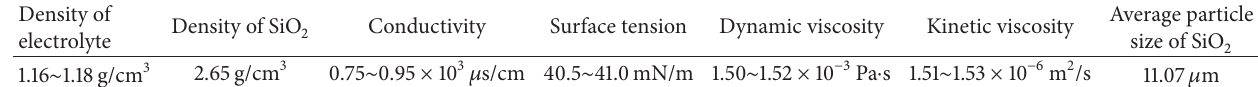
Table 1: Determination of experimental parameters.